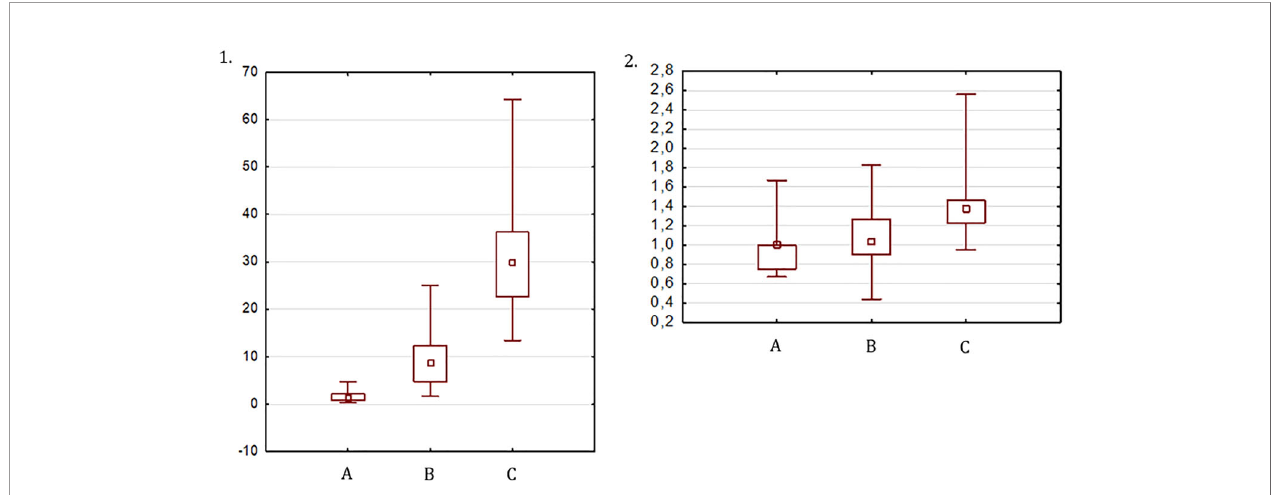
FIGURE 2 | UV (1) and FCR (2) : (A) at the start of ERT, (B) after 6-12 months of ERT, (C) after 36 months of ERT or 12 months after menarche.